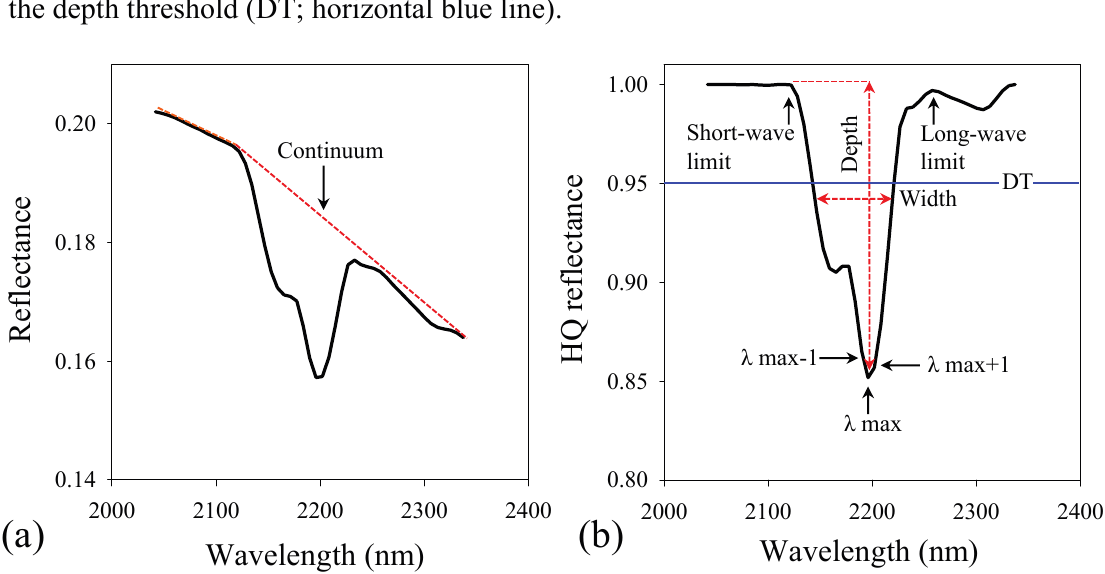
Figure 3. Schematic representation of the method used to extract feature parameters wavelength position, depth and width from the deepest absorption feature in the spectrum: ( a ) reflectance spectrum of kaolinite showing large absorption at ~2200 nm and a smaller absorption at ~2300 nm. The continuum is defined as a series of straight line segments (dotted line); ( b ) the same spectrum after removal of the continuum by dividing the reflectance by the continuum at each wavelength. The short- and long-wave limits of the feature were automatically determined. Feature depth was calculated as 1 minus the hull quotients reflectance at the deepest point of the absorption. Feature width was interpolated at half the feature depth. Wavelength position was determined by the quadratic method (Rodger et al ., 2012 [31]). The three bands used as input into the quadratic equations are located at the feature minimum ( λ max ) and bands to its left ( λ max − 1) and right ( λ max + 1). Features are parameterized only if they have a hull quotients reflectance which is less than the depth threshold (DT; horizontal blue